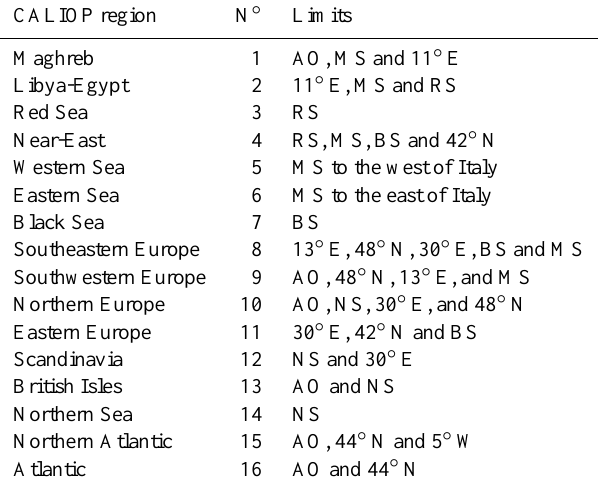
which is also much higher than in present conditions (see SeaWiFS, this is probably due to the rejections of high AOD Table3). This maximum could not be verified using avail- retrievals, thus explaining a very low AOD over the Mediter- able satellite data for this period due to the absence of AOD ranean Sea (0.147 on average). MVIRI and TOMS AOD over 1095 Figure 13 presents the annual AOD average between 1979 retrievals over continental surfaces at that time. However, it the sea (resp. 0.144 and 0.121) are also low compared to and 2010 over Europe (a), the Mediterranean Sea (b) and 1100 Northern Africa (c) for all satellite and model data sets. This could be related to important sulfate emissions in the 1980s, 1085 other datasets. TOMS AOD over Africa (0.231) is yet closer figure highlights the AOD underestimation of CZCS, TOMS which is a well-known phenomenon (e.g. Pinker et al., 2005; to MODIS and MISR retrievals in present conditions. and MVIRI in the 1980s, and MERIS and SeaWiFS later, Vautard et al., 2009; Wild, 2009). As in present conditions, which are far from the other datasets over the sea (Figure 13 Figure 13 presents the annual AOD average between 1979 LMDz-OR-INCA AOD over Northern Africa is higher than and 2010 over Europe (a), the Mediterranean Sea (b) and 1100 all the other products available over this region, while AC- Northern Africa (c) for all satellite and model data sets. This CMIP AOD over this region is similar to the 2000s. 1090 figure highlights the AOD underestimation of CZCS, TOMS The other data sets (MVIRI, TOMS and CZCS) have lower and MVIRI in the 1980s, and MERIS and SeaWiFS later, AOD over the sea. For CZCS, whose algorithm is close to which are far from the other datasets over the sea (Figure 13